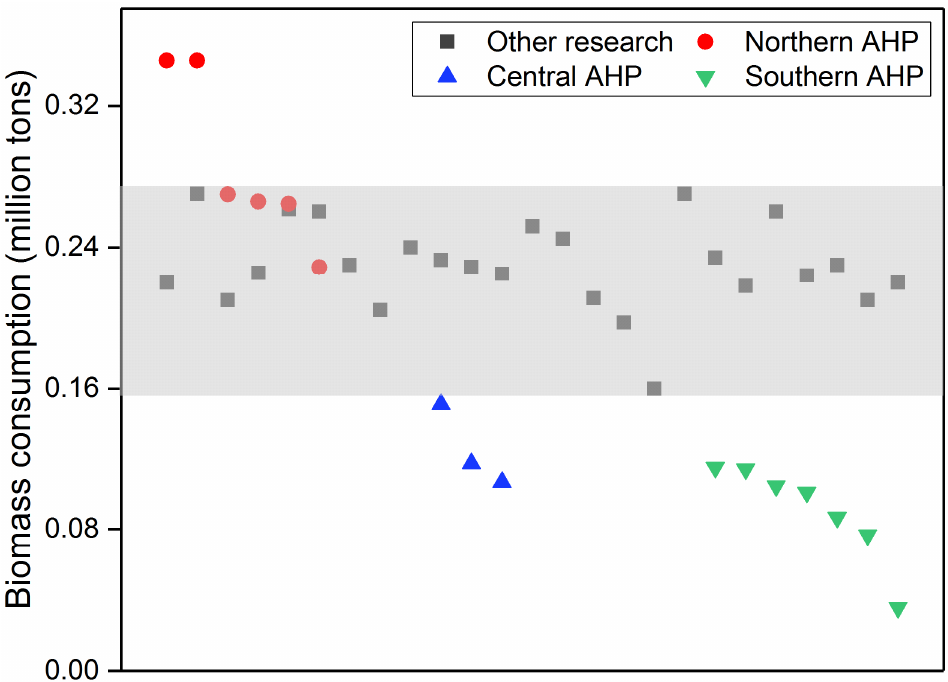
Figure 6. The maximum net theoretical available potential (NAP) of biomass in each city from AHP (with the supply assurance factor of 0.3).